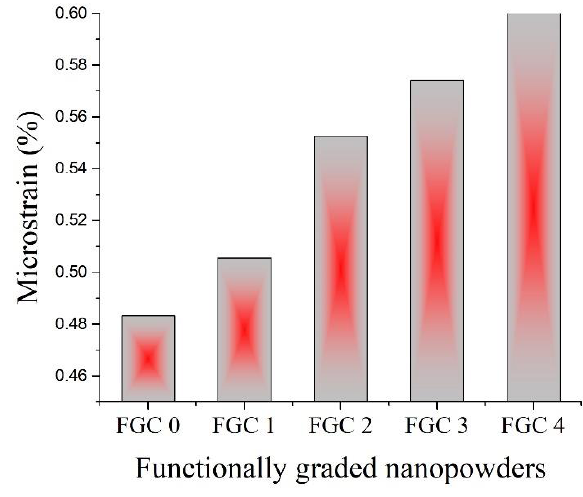
Figure 7. Micro-strain of different milled layers of FGCs.